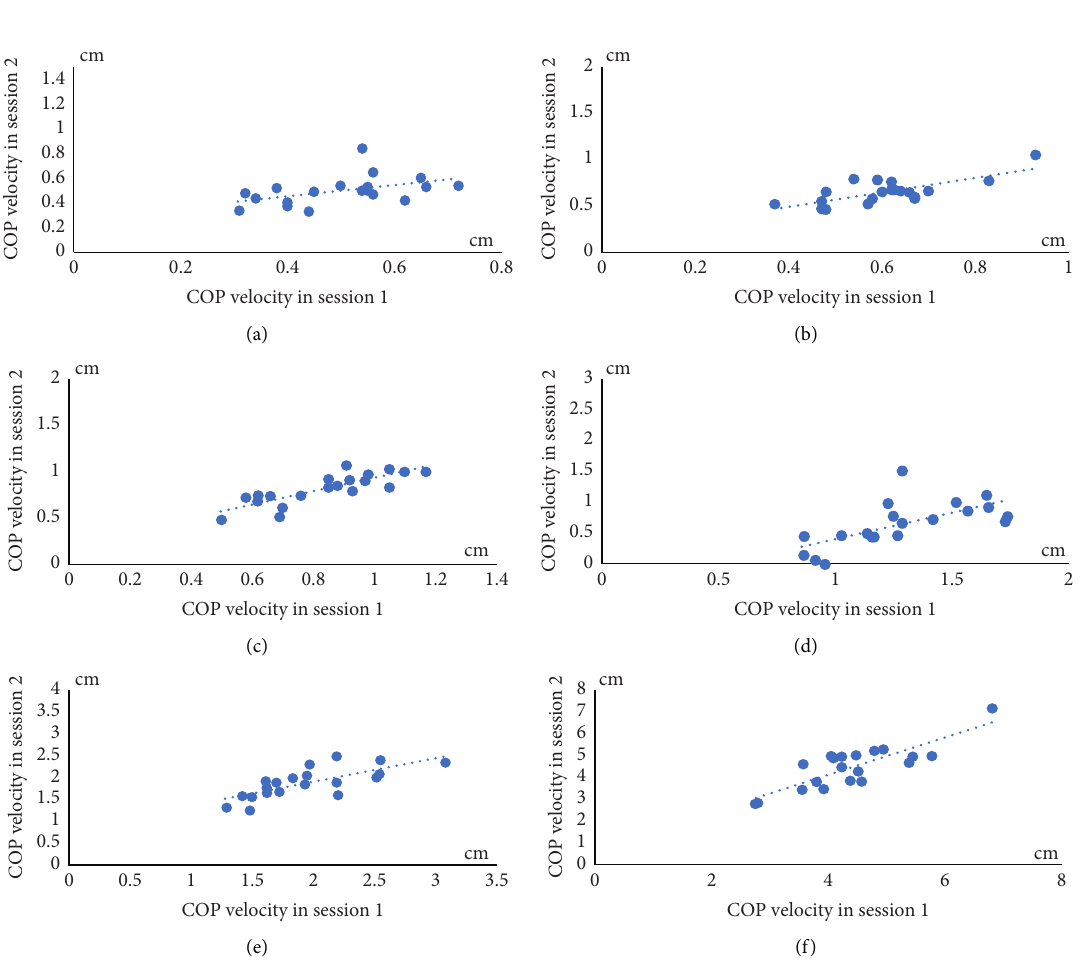
Figure 6: Scatter plots of COP velocities between sessions 1 and 2 from six testing conditions. (a) COP velocity during DLS-SW-EO. (b) COP velocity during DLS-SW-EC. (c) COP velocity during DLS-FT-EO. (d) COP velocity during DLS-FT-EC. (e) COP velocity during SLS-EO. (f) COP velocity during SLS-EC. Table 1: Means and standard deviations of COP displacements and velocities of six conditions in sessions 1 and 2. COP displacements Conditions Double leg stance with feet shoulder width apart and eyes closed Single leg stance with eyes